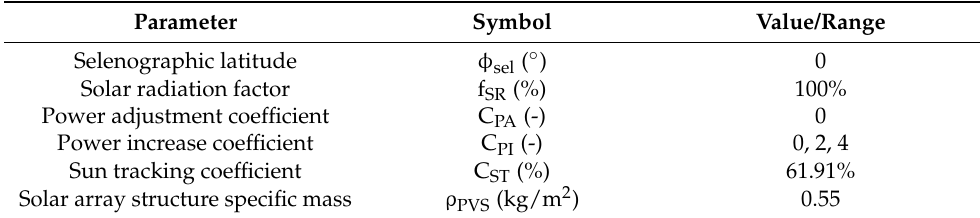
Table 15. Parameters for the base power increase coefficient study.